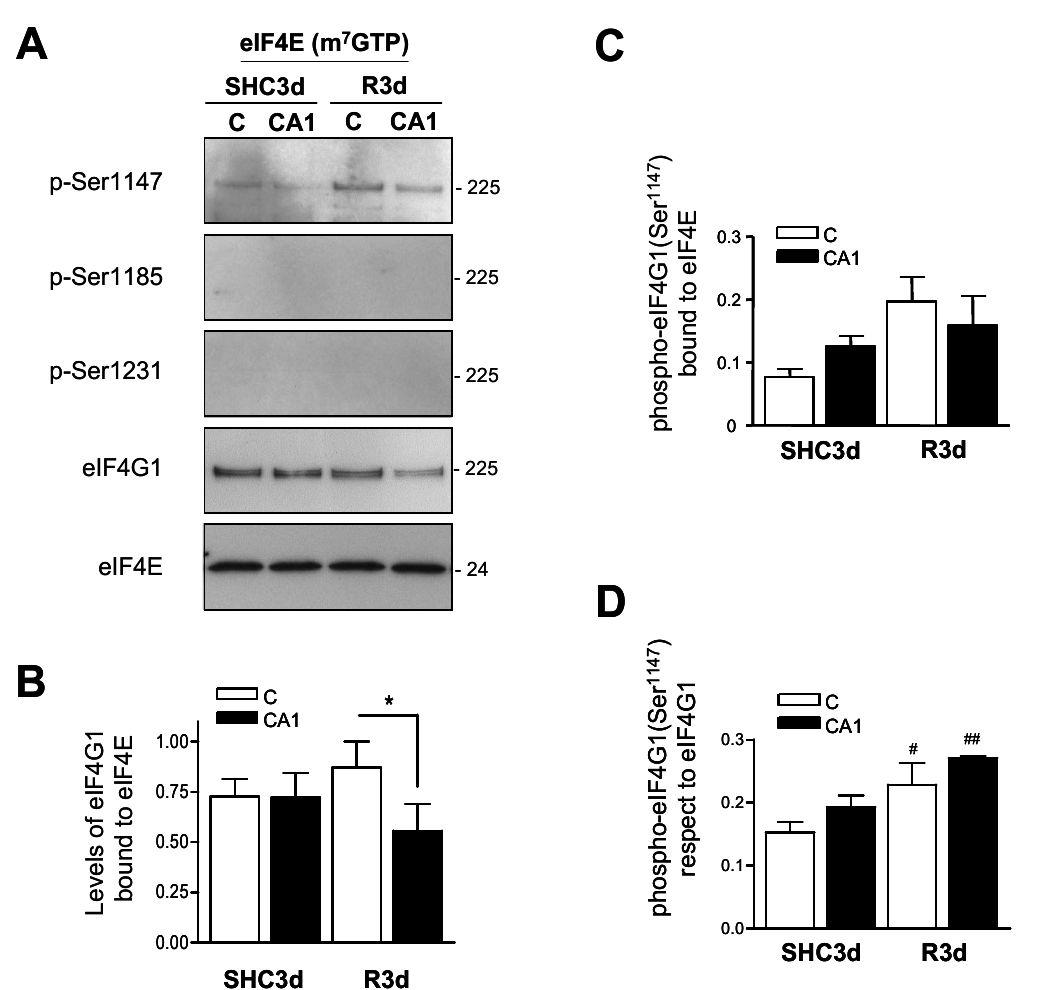
Figure 3. eIF4G1 phosphorylated at Ser 1147 is bound to eIF4E. ( A ) Samples of cerebral cortex (C) or hippocampal CA1 re- gion from control (SHC3d) and ischemic animals with reperfusion (R3d), were bound to a cap-containing matrix (m 7 GTP-Sepharose) and eIF4E and eIF4E-associated proteins were analyzed by SDS-PAGE followed by Western blotting for anti-phospho-eIF4G1 Ser 1147 (p-Ser1147), anti-phospho-eIF4G1 Ser 1185 (p-Ser1185), anti-phospho-eIF4G1 Ser 1231 (p-Ser1231), anti-eIF4G1 (N-20) (eIF4G1), and anti-eIF4E (eIF4E) antibodies. Among phospho-eIF4G1 forms, only eIF4G1 phosphorylated at Ser 1147 was detected. Molecular mass (kDa) of protein markers is stated in the right. The figures are representative results of 4–6 independent experiments from 4–6 animals. Full original images of the Western blots are shown in the Supplementary Material (Figure S3) ( B ) Quantification of eIF4G1 bound to eIF4E, and ( C ), quantification of eIF4G1 phosphorylated at Ser 1147 bound to eIF4E with respect to eIF4E levels (ratios). ( D ) Relative levels of eIF4G1 phosphorylated at Ser 1147 bound to eIF4E with respect to eIFG1 levels. In all experiments, eIF4E was detected with an- ti-eIF4E antibody, and no significant differences between eIF4E levels were found. Bar graphs represent the mean of 4–6 independent experiments from 4–6 animals; error bars indicate SE. Statistical significance were performed by New- man–Keuls post-test (# p < 0.05; ## p < 0.01) or by Student’s t-test (* p < 0.05), after significant ANOVA ( p < 0.05), com- pared with their respective control, or between the cerebral cortex and CA1 samples (indicated by